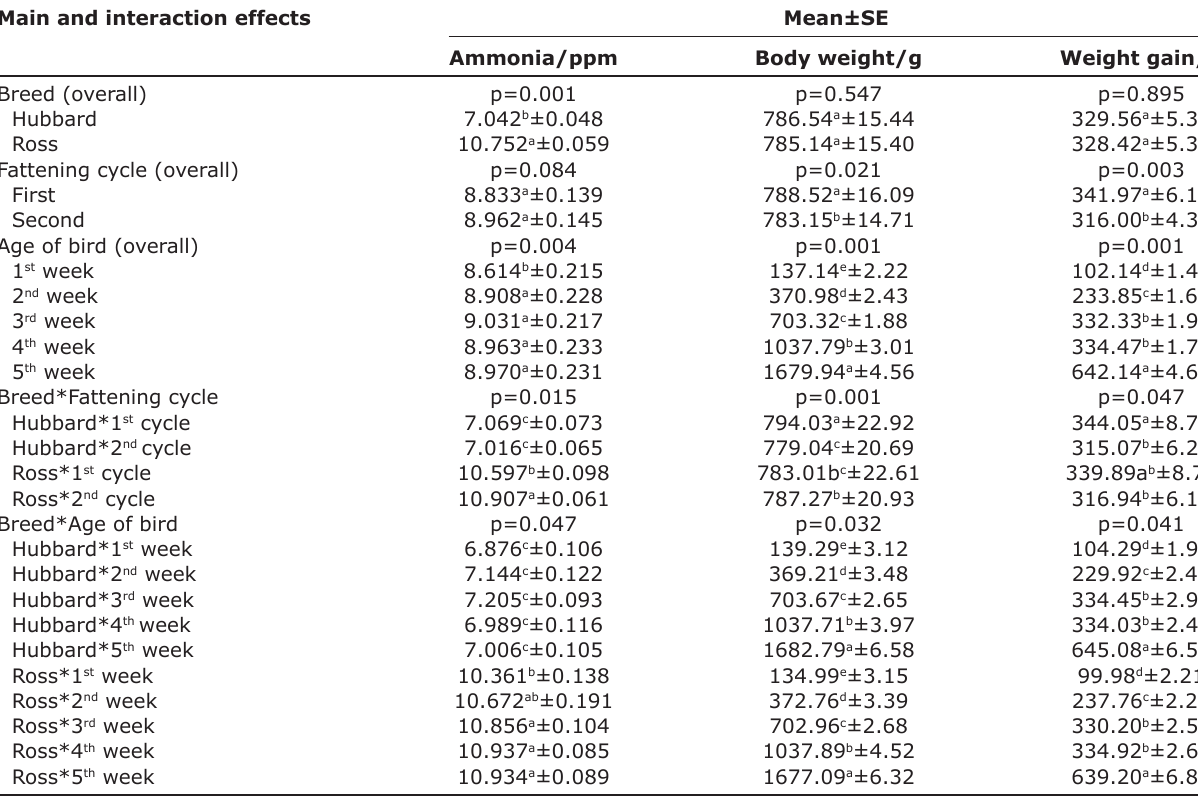
Table-1: Effects of breed, fattening cycle, and age of birds (weeks) and their interactions on concentration of ammonia, body weight, and BWG. Main and interaction